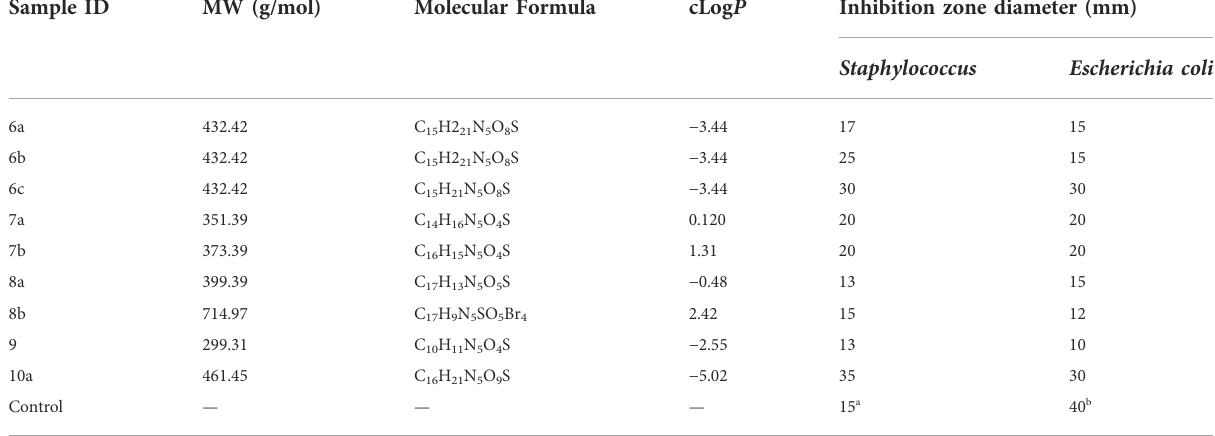
TABLE 5 Antibacterial activity (inhibition zone diameter in mm) of the tested compounds.